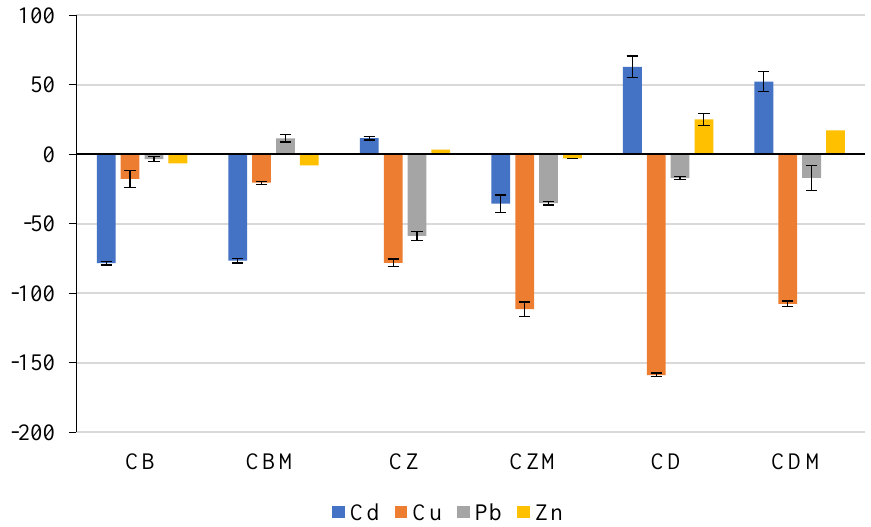
Figure 3. Value of the heavy metal immobilization factor (IFHM) in composts. C—biomass without the addition of functionalized materials and bacterial metabolites, CB—biomass with the addition of biochar, CBM—biomass with the addition of biochar and bacterial metabolites, CZ—biomass with the addition of zeolite, CZM—biomass with the addition of zeolite and bacterial metabolites, CD—biomass with the addition of diatomite, CDM—biomass with the addition of diatomite and bacterial metabolites.